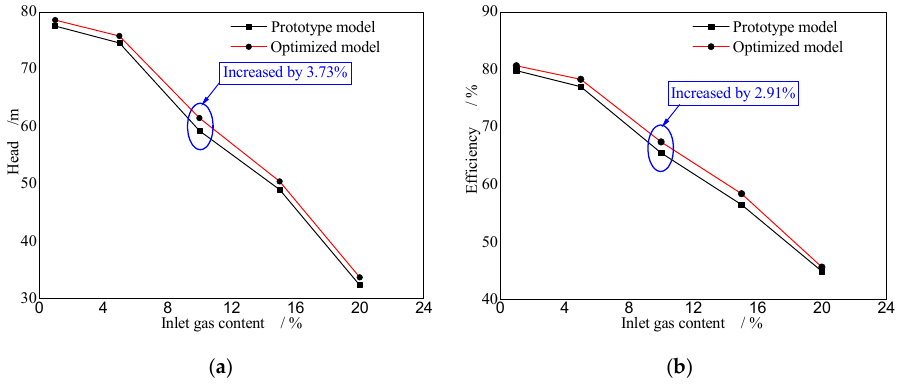
Figure 12. Performance comparison of the mixed transport pump before and after optimization. ( a ) Head comparison; ( b ) Efficiency comparison.